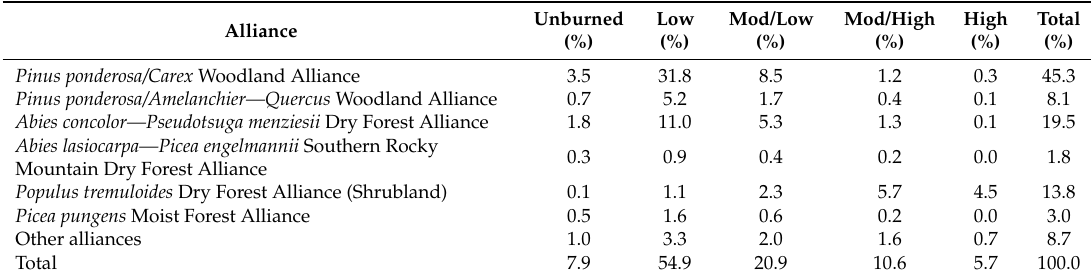
Table 3. Severity proportions by vegetation alliance. The Grand Canyon fire staff adjusted the original MTBS default severity class thresholds to match the CBI field data for each individual fire.